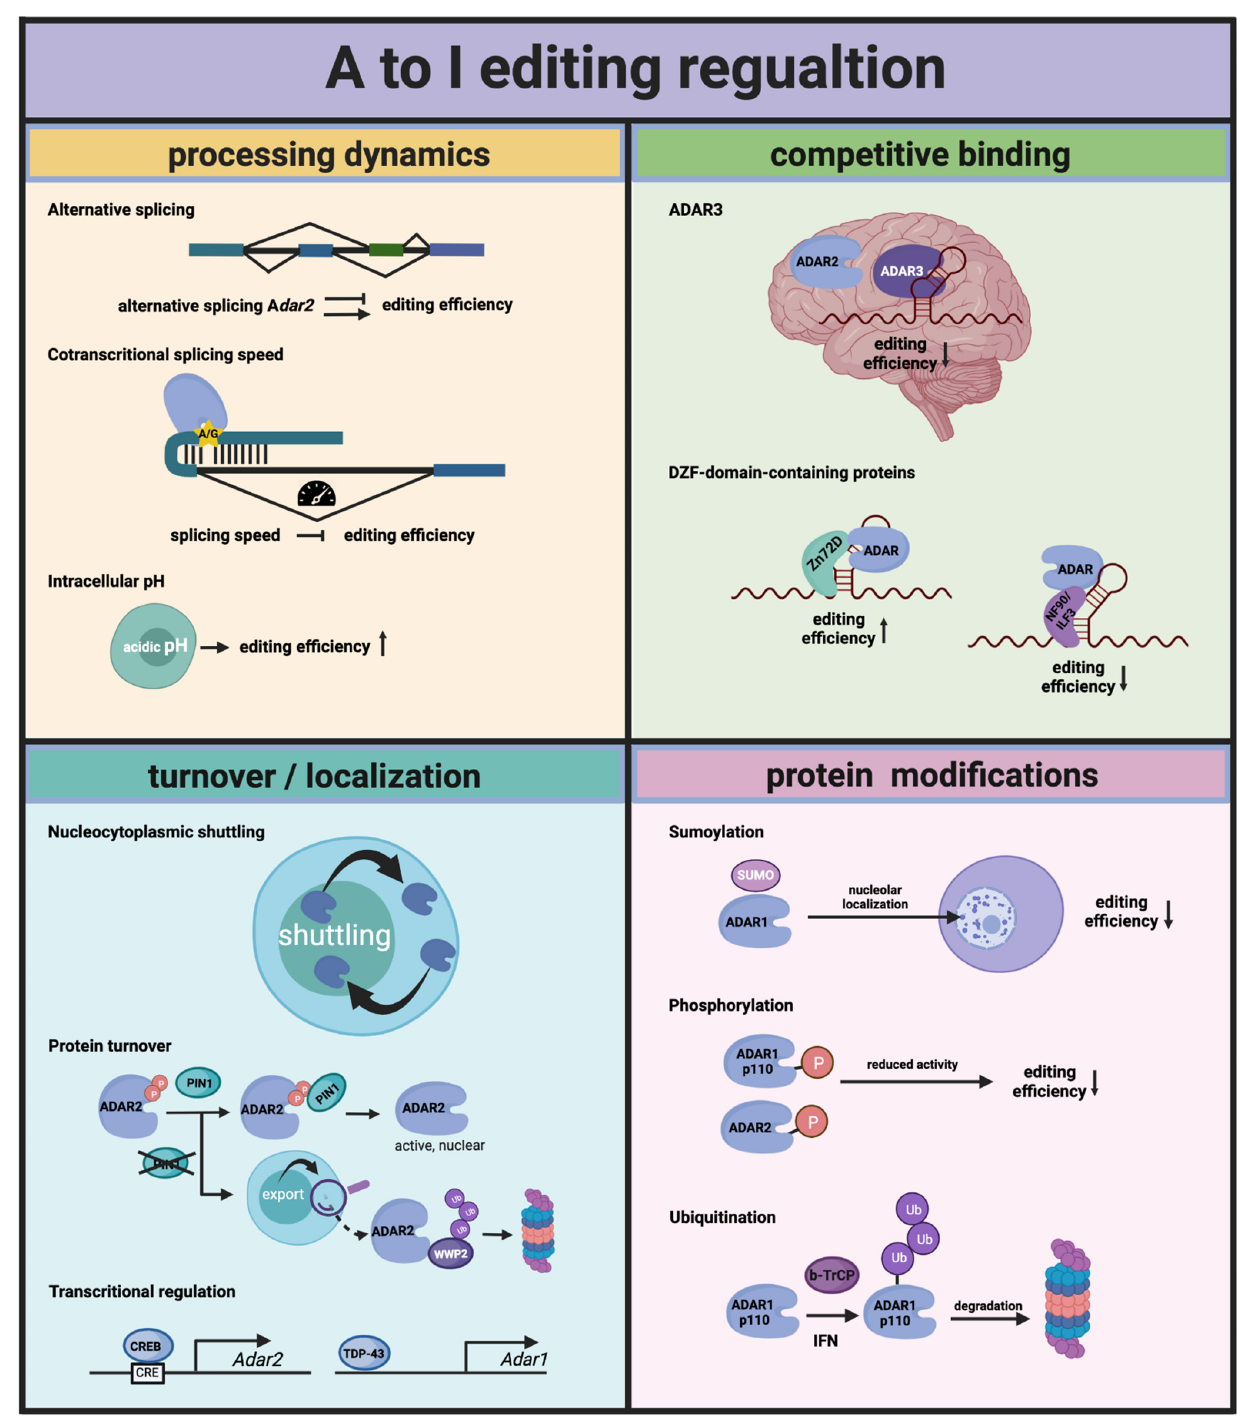
Figure 2. Regulation of A to I editing by Adenosine Deaminases Acting on RNA (ADARs). Adar transcripts can be alternatively spliced, resulting in premature termination codons or the expression of an ADAR protein with modified editing activity. The time for ADARs to edit sites that consist of secondary structures in which intronic sequences are contained is restricted by the speed of the splicing that removes the intron. Intracellular acidic pH seems to favor the flipping out of the adenosine that is edited, resulting in higher editing rates. Overall, the editing rates for different types of editing sites (intronic, exonic and UTRs) is controlled by the ability of the ADAR proteins to shuttle between the nucleus and the cytoplasm. PIN1, a prolyl-isomerase, stabilizes ADAR2 in the nucleus and thereby regulates editing of the nuclear targets of ADAR2. Further, levels of ADARs can be regulated on a transcriptional level, by CREB for ADAR2 and by TDP-43 for ADAR1. Competitive binding of other RNA-binding proteins in general is another way to regulate editing. In many cases,